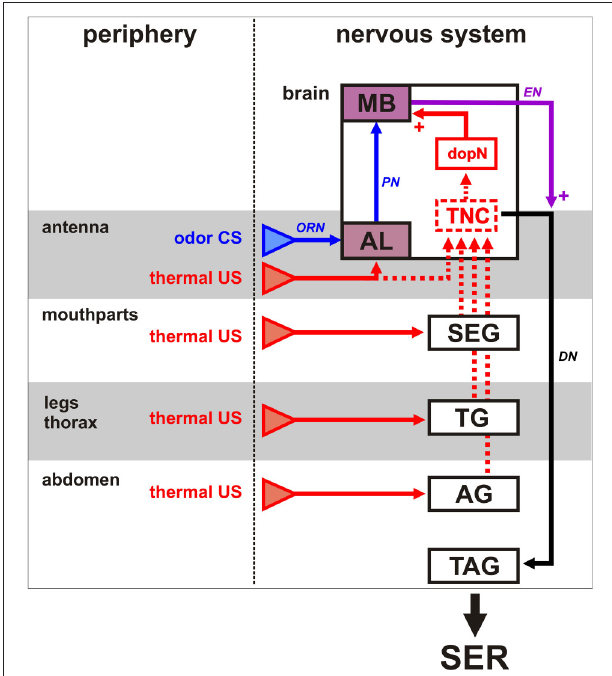
FIGURE 9 | Working model of aversive olfactory conditioning of SER using a thermal US. Putative pathways involved in (A) the expression of SER after thermal stimulation, (B) the acquired SER after learning a CS-US association, are shown. (A) At the periphery, stimulation of the different structures with a high temperature is thought to activate thermosensitive neurons (possibly class IV multidendritic neurons), which would first project to the respective relays on the ventral nerve cord, the subesophageal ganglion (SEG), thoracic ganglia (TG), or abdominal ganglia (AG). As a second step, interneurons would project to a thermal/nociceptive center (TNC) in the brain. Antennal thermal stimulation induces activity in the antennal lobe (AL) but possibly also activates the TNC. Activation of this center would stimulate premotor descending neurons (DN) which would in turn trigger stinging motor patterns in the terminal abdominal ganglion (TAG), producing SER ( Ogawa et al., 1995 ). (B) Olfactory learning: odorants are detected on the antenna by olfactory receptor neurons (ORNs) projecting to the AL. Then information is prominently conveyed to the mushroom bodies (MB) by projection neurons (PN). Activation of dopaminergic neurons (dopN) by the TNC would inform the olfactory pathway of the aversive thermal reinforcement. Associative plasticity at the level of MB extrinsic neurons (EN) feeding onto the sting premotor descending neurons would allow the CS to elicit SER after